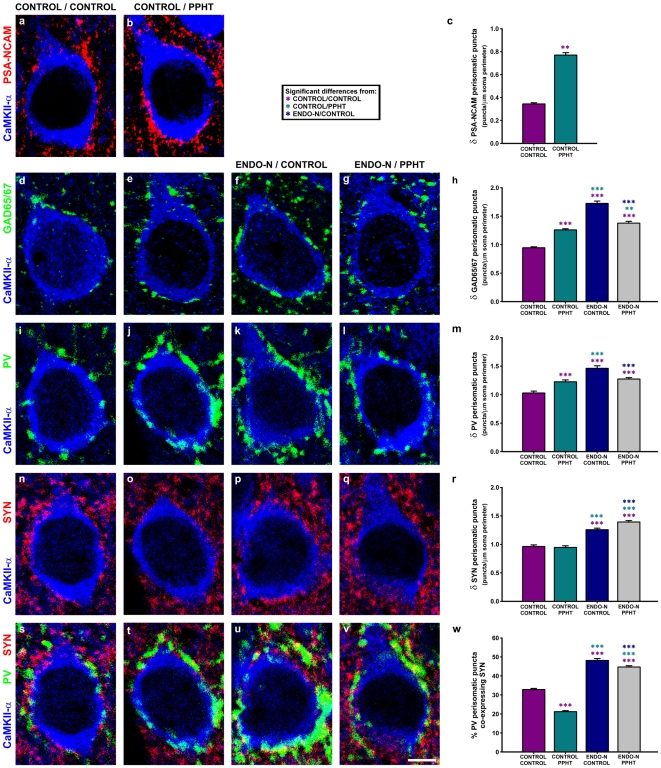
Confocal microscopic analysis of PSA-NCAM, GAD65/67, PV and SYN expressing puncta in the perisomatic region of mPFC pyramidal neurons after Endo-N or PPHT treatments and their combination.Focal planes of pyramidal neuron somata (immunolabeled for CaMKII-α) showing the changes in the perisomatic density of PSA-NCAM (a–b), GAD65/67 (d–g), PV (i–l) and SYN (n–q) expressing puncta after the different treatments, as can be observed in graphs (c), (h), (m) and (r), respectively. (s–w) Focal planes and graph showing the changes on the percentage of PV expressing puncta co-expressing SYN after treatment. Asterisks in bars indicate statistically significant differences between groups (see graph legend) after unpaired Student's t-test (c) or one-way ANOVA (h, m, r, w) followed by Bonferroni's correction; p<0.05 (*), p<0.01 (**), p<0.001 (***).